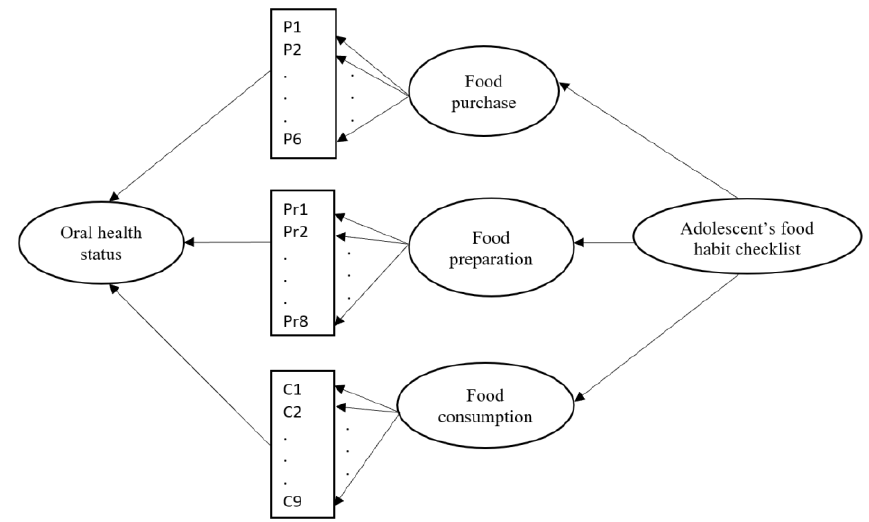
Figure 1. Research